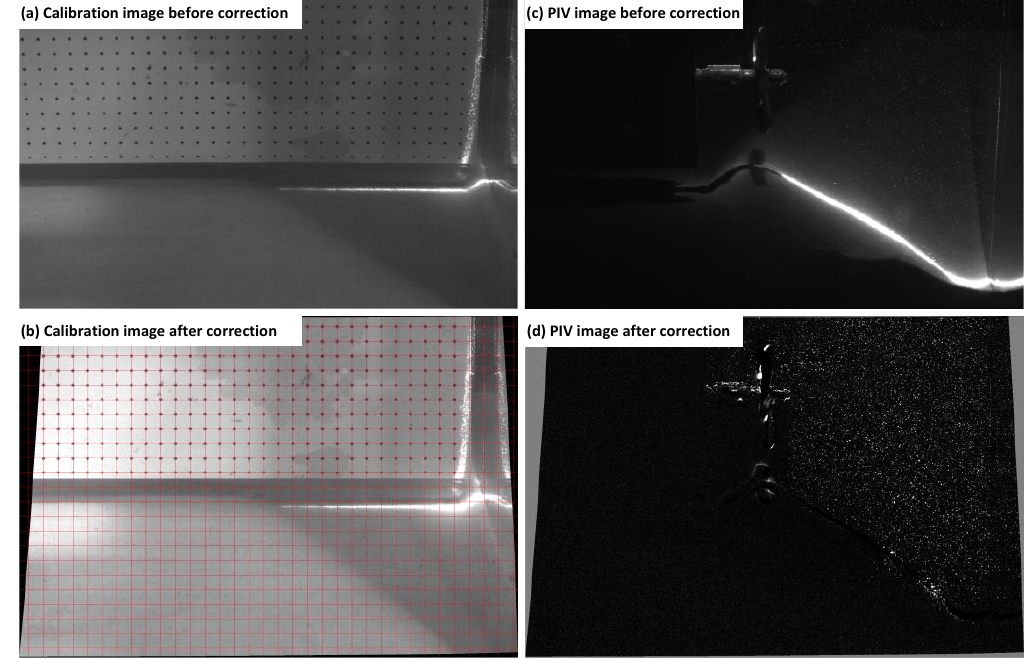
Figure 2. Comparison of calibration and PIV images before and after correction.